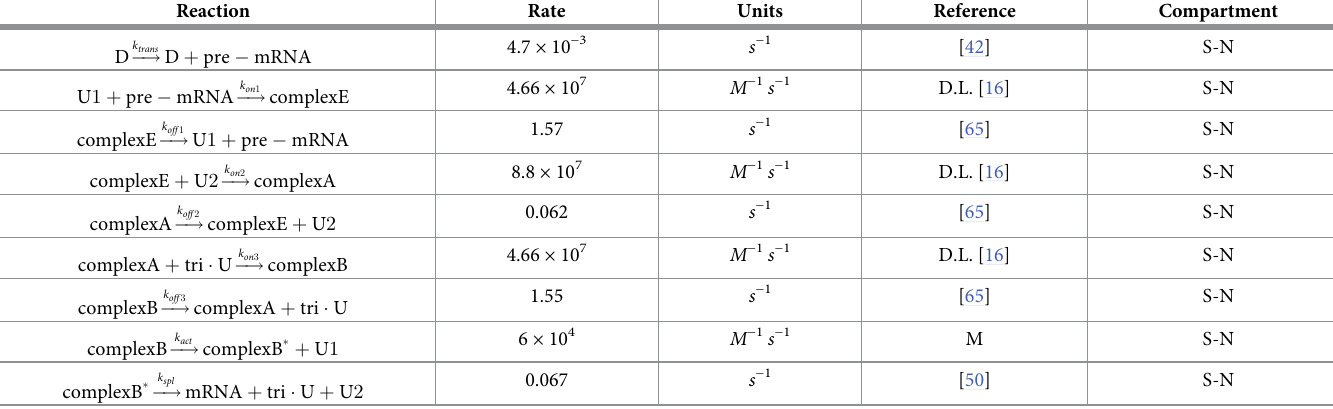
Table 3. Spliceosome assembly and splicing reaction. Abbreviations are: DNA (D), U1snRNP (U1), U2snRNP (U2), U4/U6 � U5snRNP (tri � U), model assumption (M), diffusion-limited (D.L.), nuclear speckles (S) and nucleus (N).